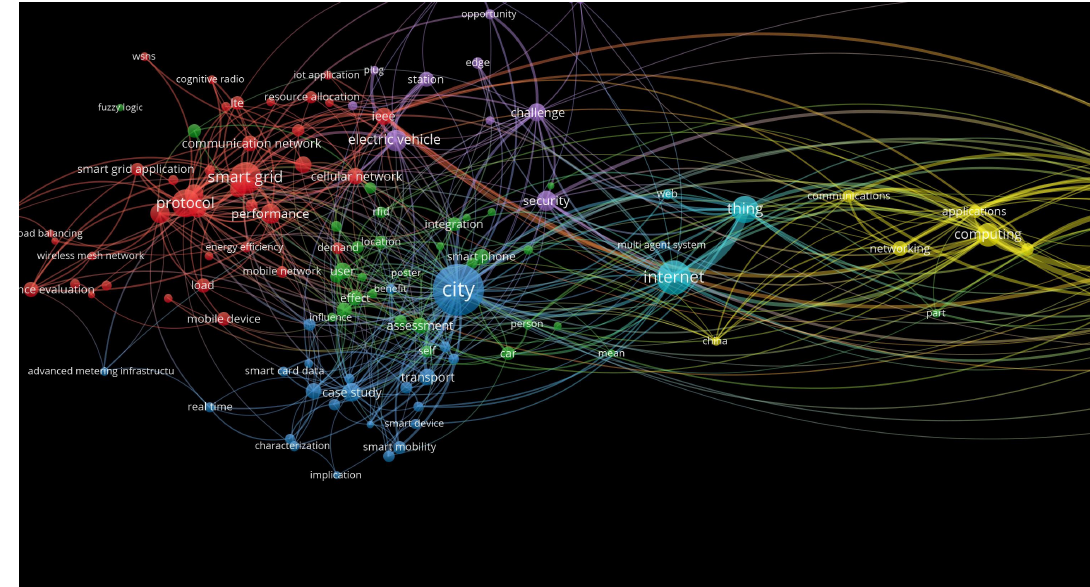
Figure 1. Map of current research trends based on the co-occurrence of keywords in Scopus database for the years 2016–2019. The size of the point and font representing each term show the frequency with which this key word occurs. Source: authors’ own study using VOSviewer